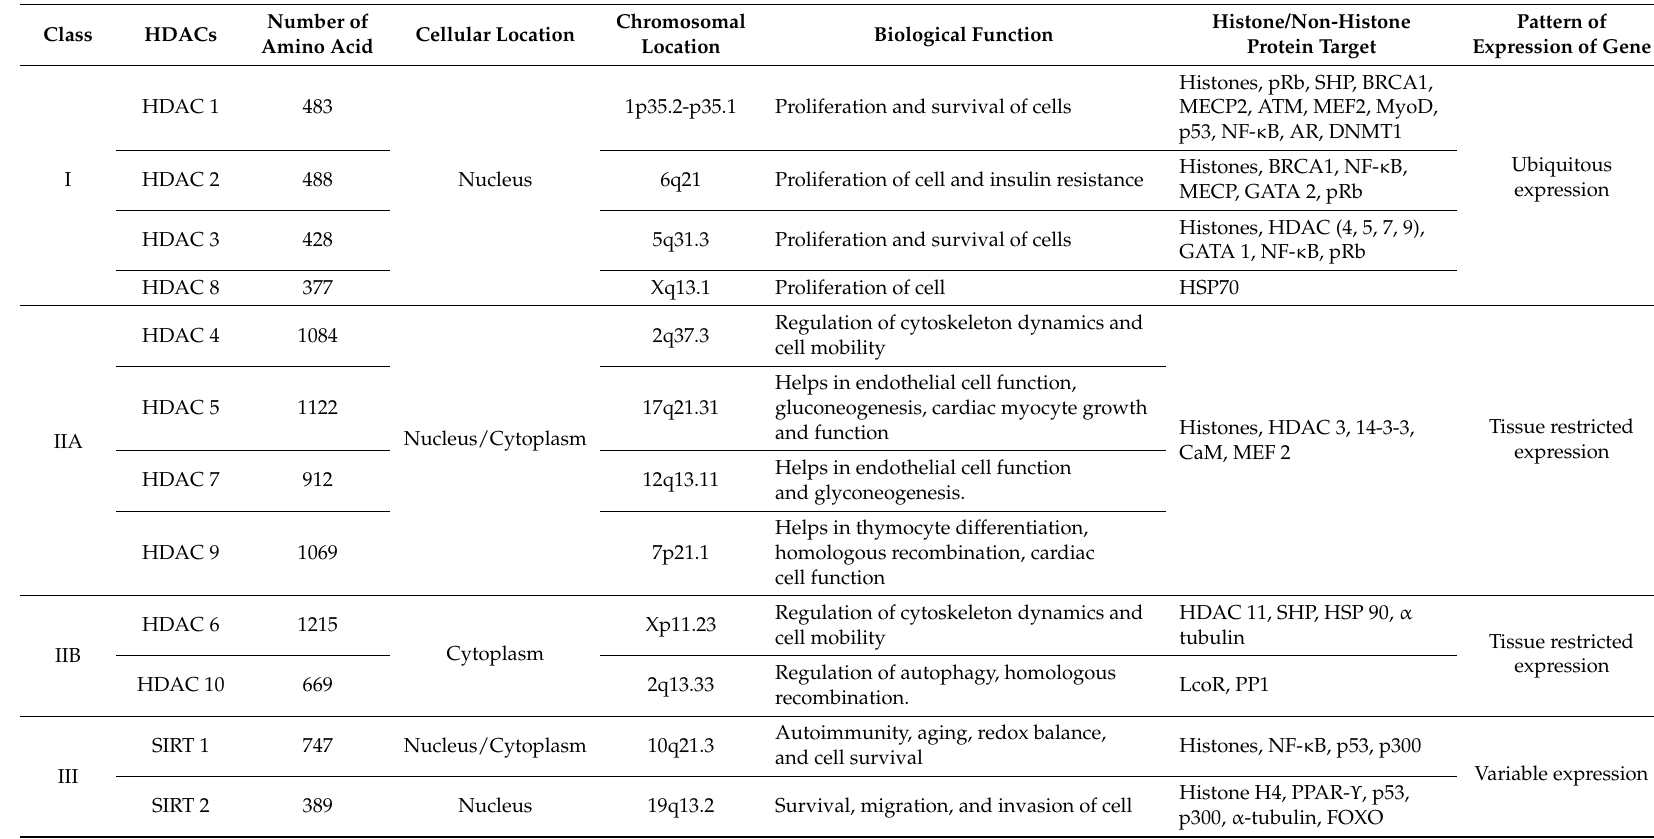
Table 1. Histone deacetylase (HDAC) enzymes classification, number of amino acids, localization, function, protein targets and expression pattern.